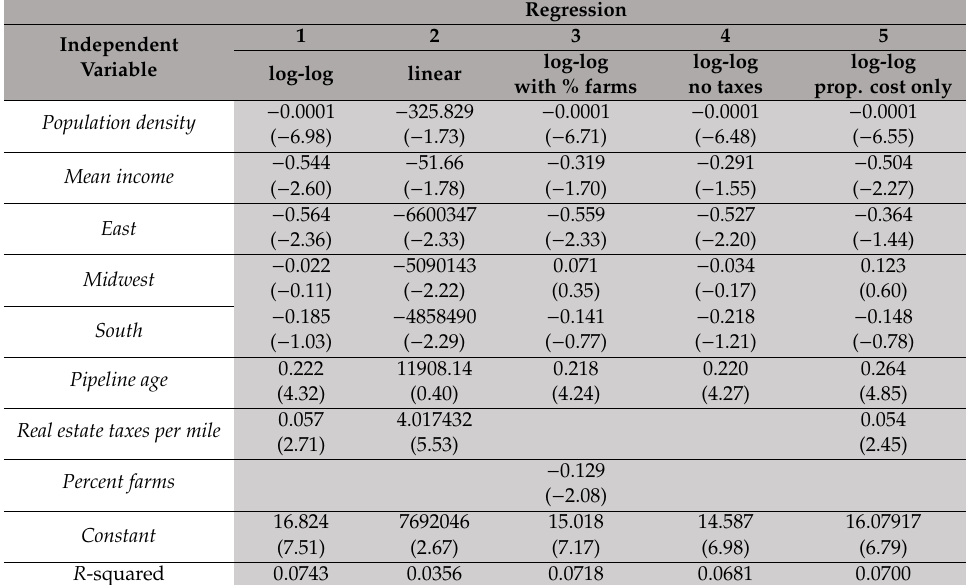
Table 5. Additional regressions (dependent variable: Cost of incident. t-values are in